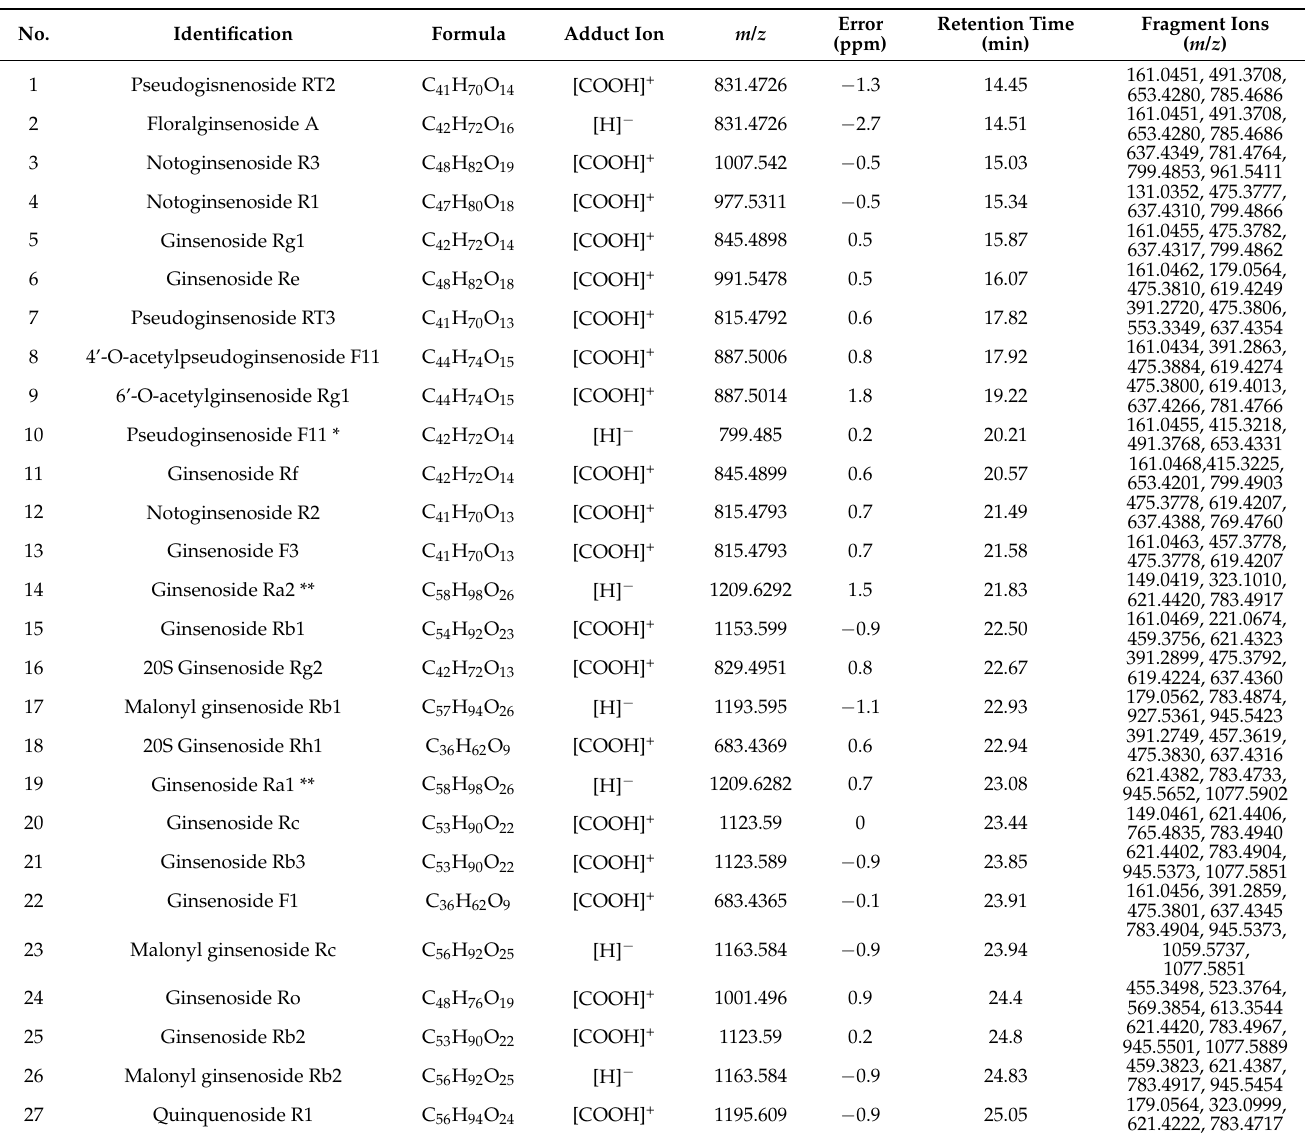
Table 2. Detected compounds in Ginseng by HPLC